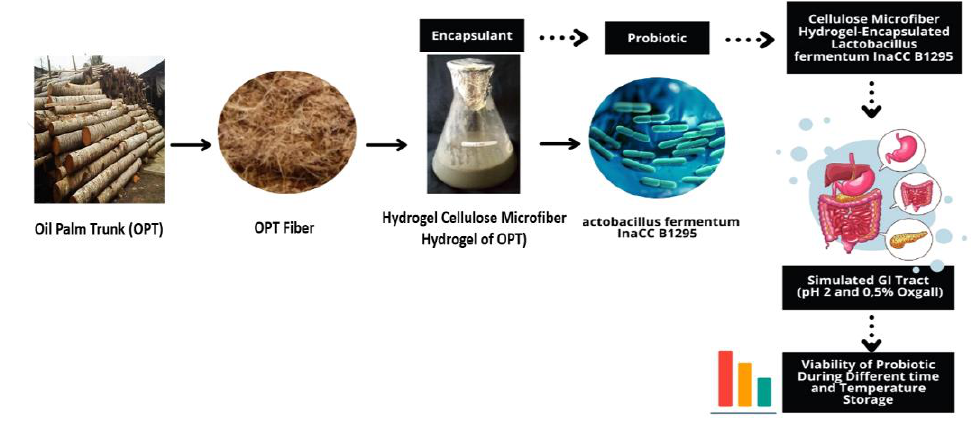
Figure 1. Flowchart of the research